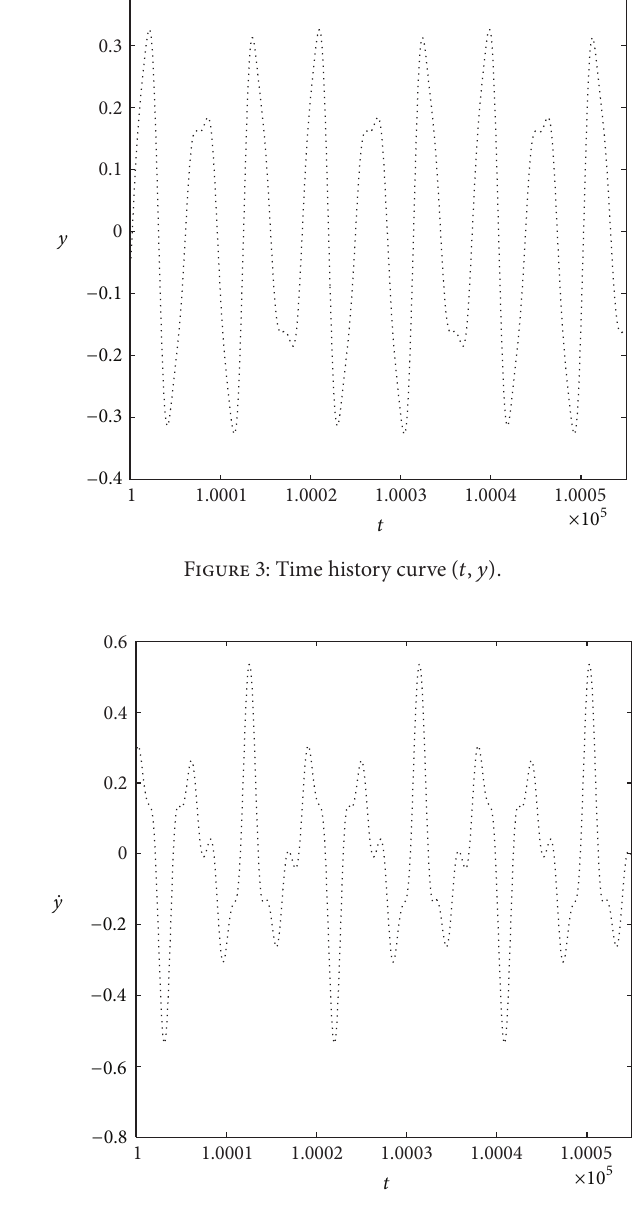
Figure 4: Time history curve (𝑡, ̇𝑦)